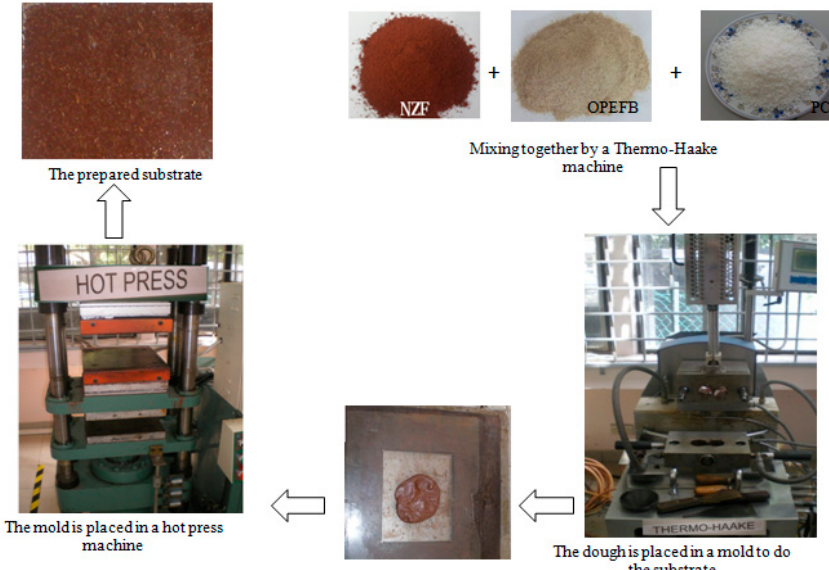
Figure 1. Substrate fabrication steps.